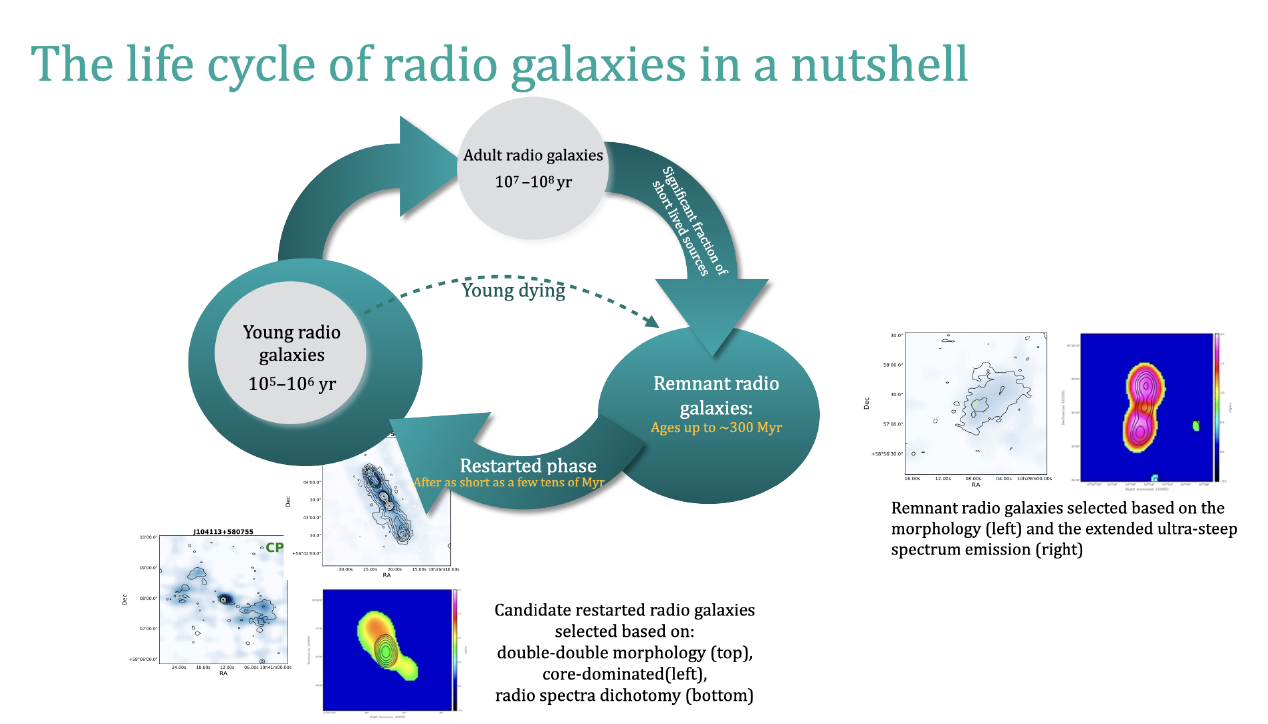
Figure 5. Sketch based on the results obtained in the Lockman Hole region by [34,37–39]. See Section 6 for more details. The example of remnant and restarted radio sources are taken from Figure